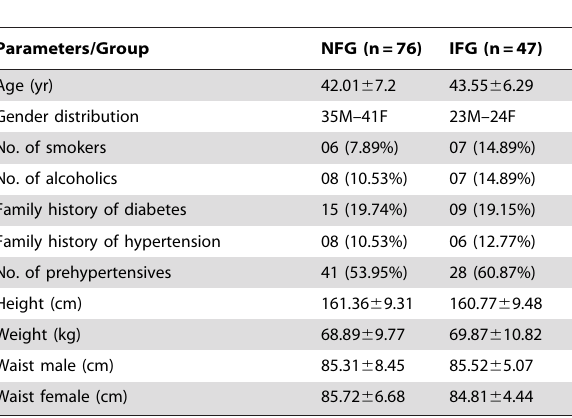
Table 1. Distribution of anthropometric measurements